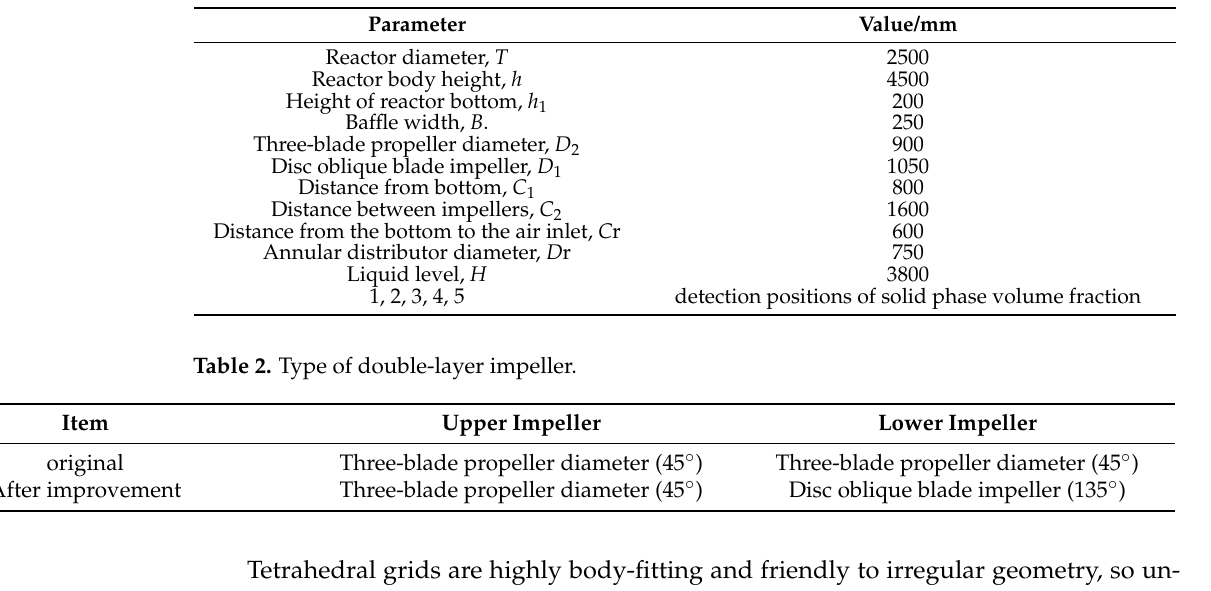
Table 3. Three-phase physical properties.